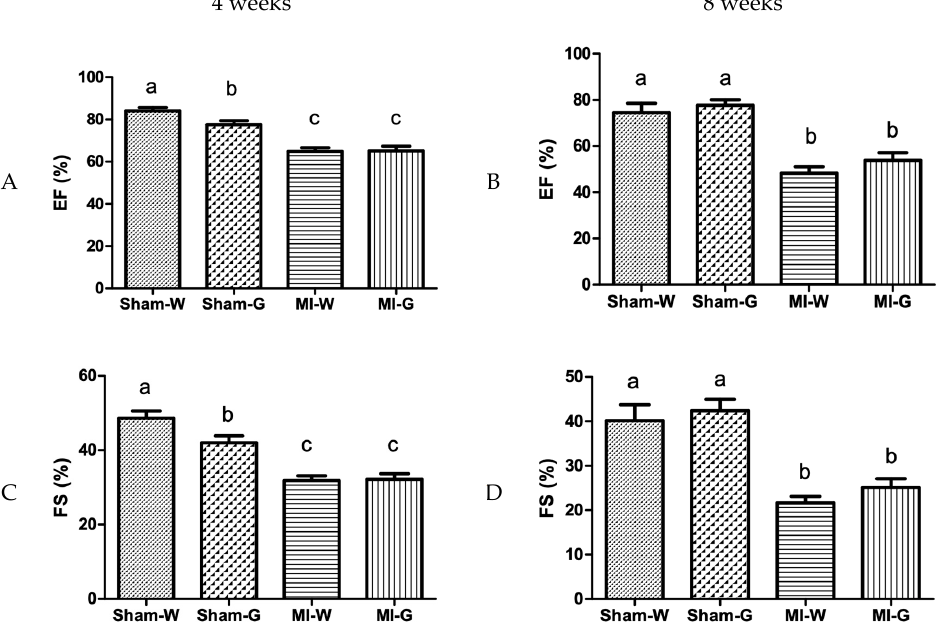
Figure 3. Effect of ginseng berry extract on systolic heart function. ( A ) Ejection fraction (EF) at 4 weeks; ( B ) EF at 8 weeks; ( C ) fractional shortening (FS) at 4 weeks; ( D ) FS at 8 weeks. Values presented are mean ± SEM. Bars with differing letter are significantly different, p < 0.05. Sham-W: Sham MI treated with distilled water ( n = 8); Sham-G: Sham MI treated with GBE 150 mg/kg/body weight/day ( n = 8); MI-W: MI treated with distilled water ( n = 12–14); MI-G: MI treated with GBE 150 mg/kg/body weight/day ( n = 12 – 14).